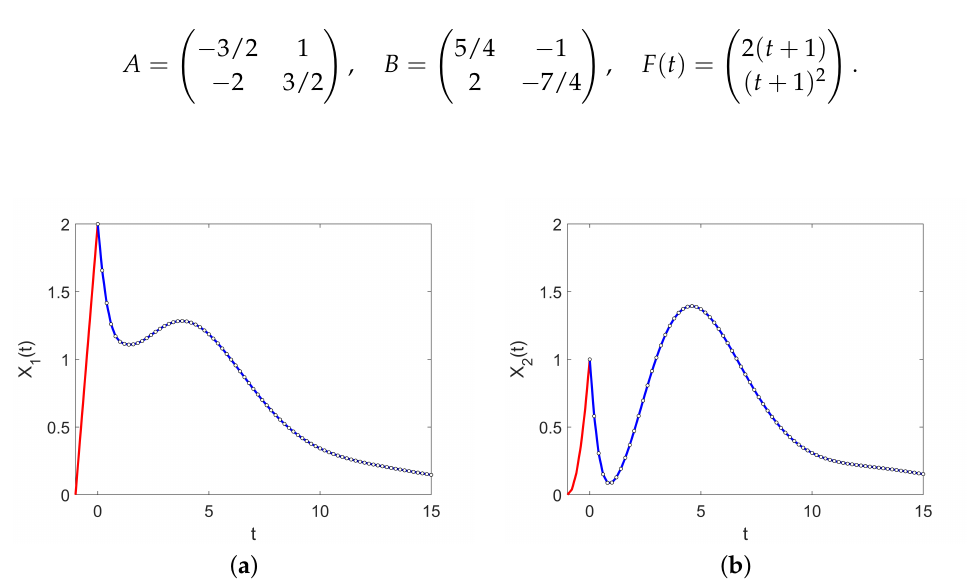
Figure 1. Exact solutions (lines) and numerical solutions provided by the exact scheme (points) for the two components of Example 1. ( a ) First component, X 1 ( t ) . ( b ) Second component, X 2 ( t )